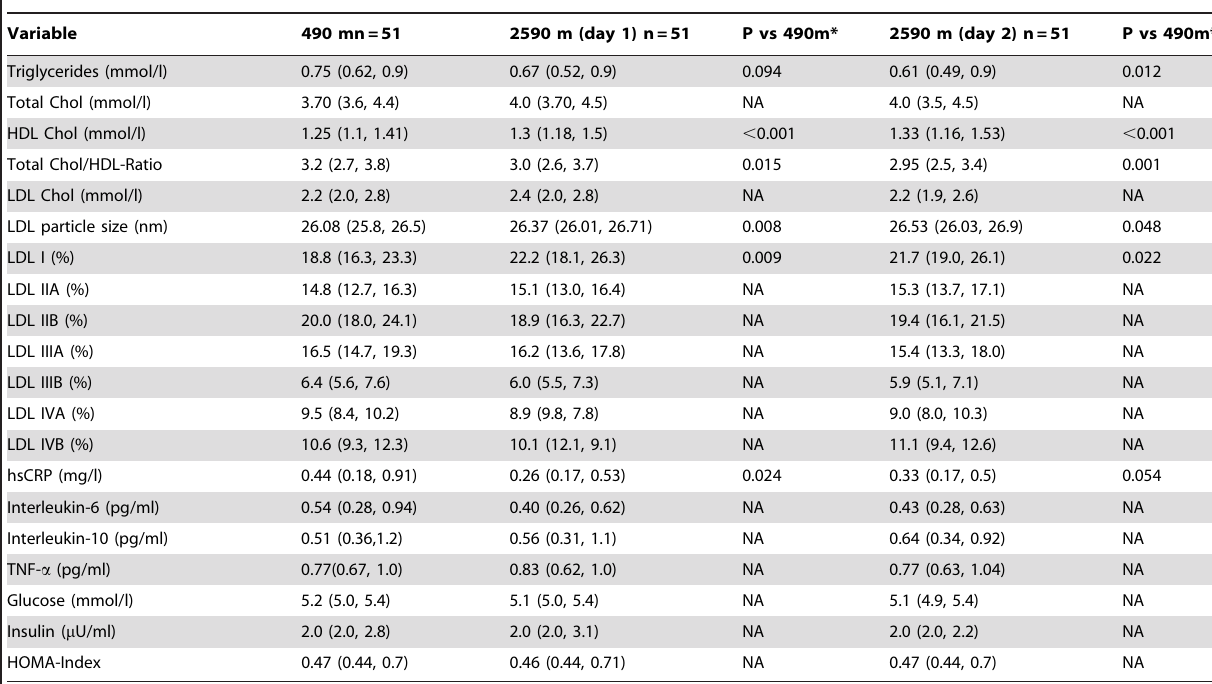
Values are medians (quartiles). Chol=cholesterol; HDL= high density lipoprotein; LDL= low density lipoprotein, LDL I, IIA, IIB, IIIA, IIIB, IVA, IVB=LDL subfractions. HsCRP= highly sensitive C-reactive protein, TNF- a = Tumor necrosis factor a . HOMA-index= Homeostatic model assessment-index=fasting insulin ( m U/ml) x fasting glucose (mmol/l)/22.5. *P-values refer to post-hoc comparisons of variables with P ANOVA , 0.05. NA: P ANOVA . 0.05.